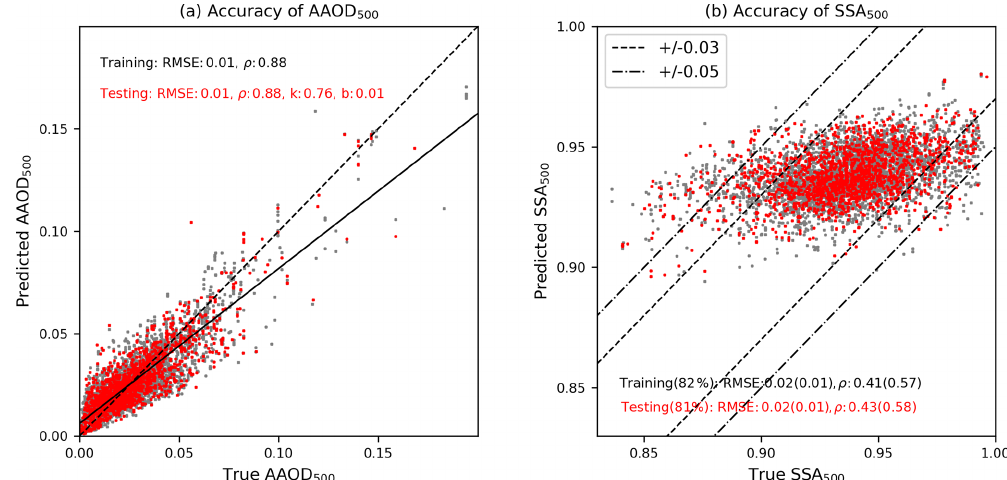
Figure 8. The accuracy of the trained SVR model: (a) the predicted AAOD at 500nm against the true AAOD at 500nm. The dashed line is the 1 : 1 line, and the solid line is the linear fitting for the testing data set; (b) the predicted SSA at 500nm against true SSA at 500nm. Gray and red indicate samples in training and testing data sets, respectively. The values in parentheses are the statistics for samples that fall within an AERONET uncertainty of 0.03.